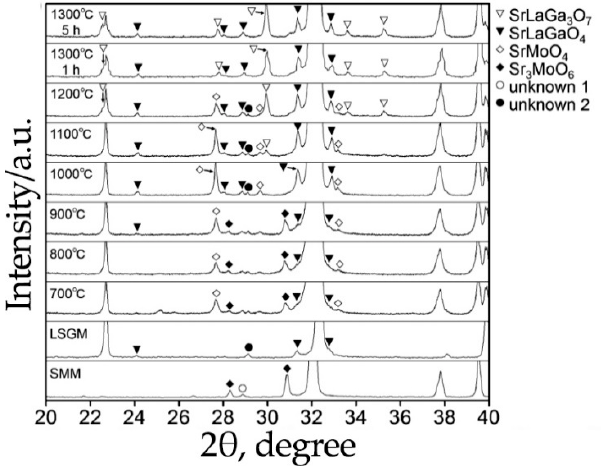
Figure 9. XRD patterns recorded for mixtures of Sr 2 MgMoO 6– δ and LSGM calcined in air at different temperatures. Reproduced with permission [99]. Copyright 2018, The Ceramic Society of Japan.